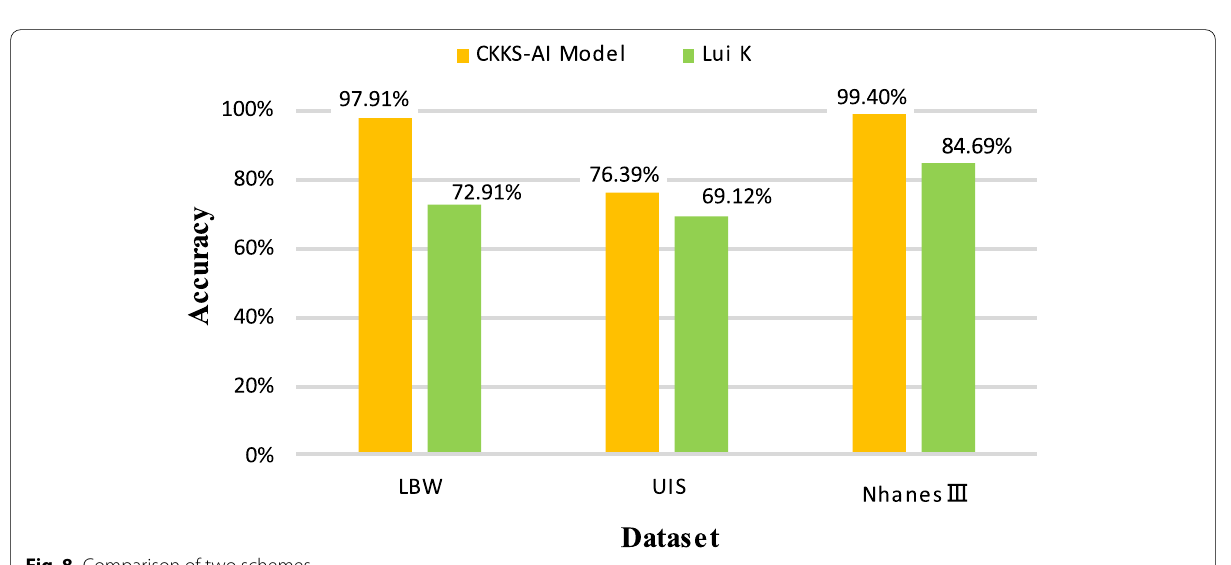
Fig. 8 Comparison of two